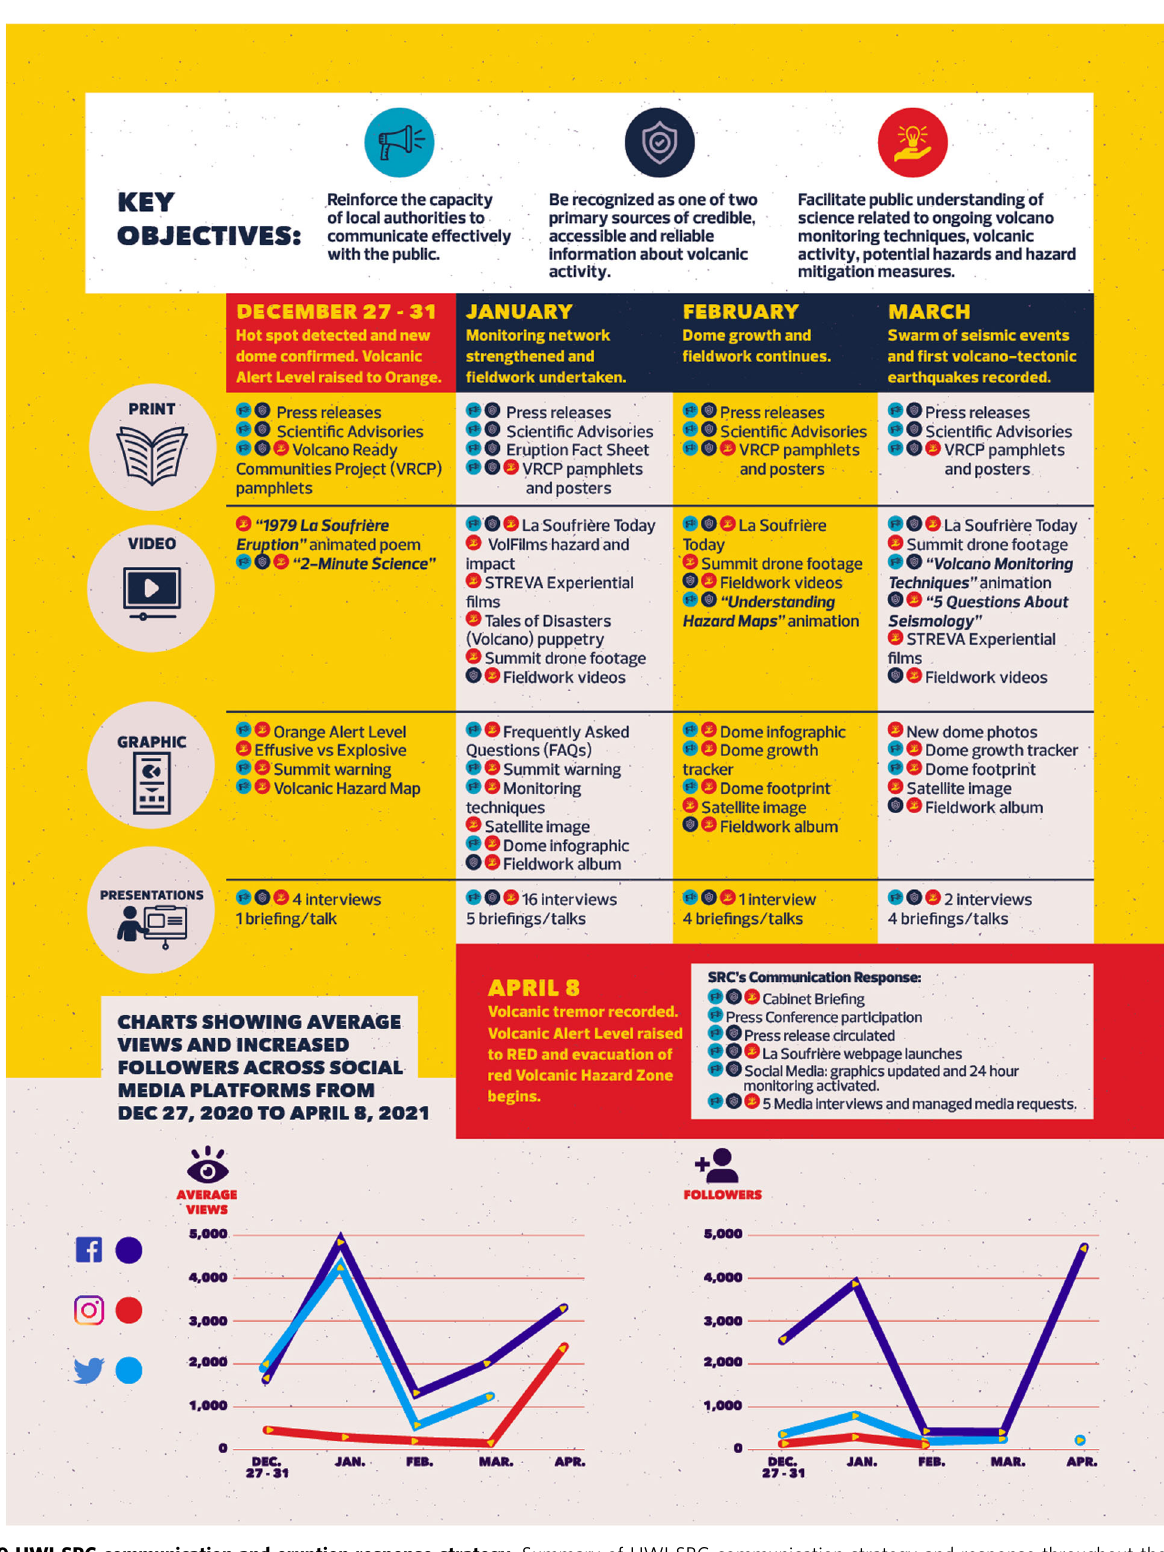
Fig. 10 UWI SRC communication and eruption response strategy. Summary of UWI SRC communication strategy and response throughout the 2020 – 2021 eruption of La Soufrière, St. Vincent